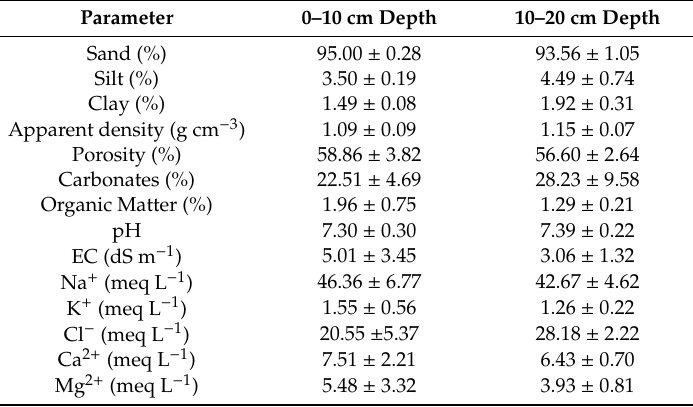
Figure 2. Climate charts including mean temperatures, rainfall and evapotranspiration during 2015 ( a ) and 2017 ( b ). Mean temperature is shown in red, rainfall in blue and evapotranspiration in green. Climatic data were from the nearest meteorological station in Benifaio, provided by the Agroclimatic Information System for Irrigation (SIAR) [24]. Table 4. Soil characteristics in the salt marsh ‘Mallada del Canyar’, where the most abundant population of T. maritimum is located. Values represent means followed by SE ( n =